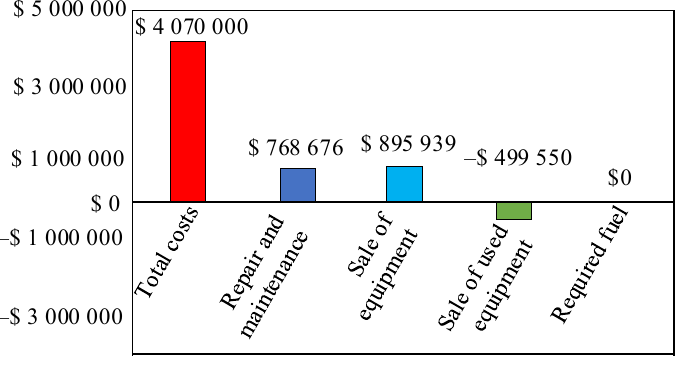
Fig. 6. Discounted costs of the whole project separately for different types of